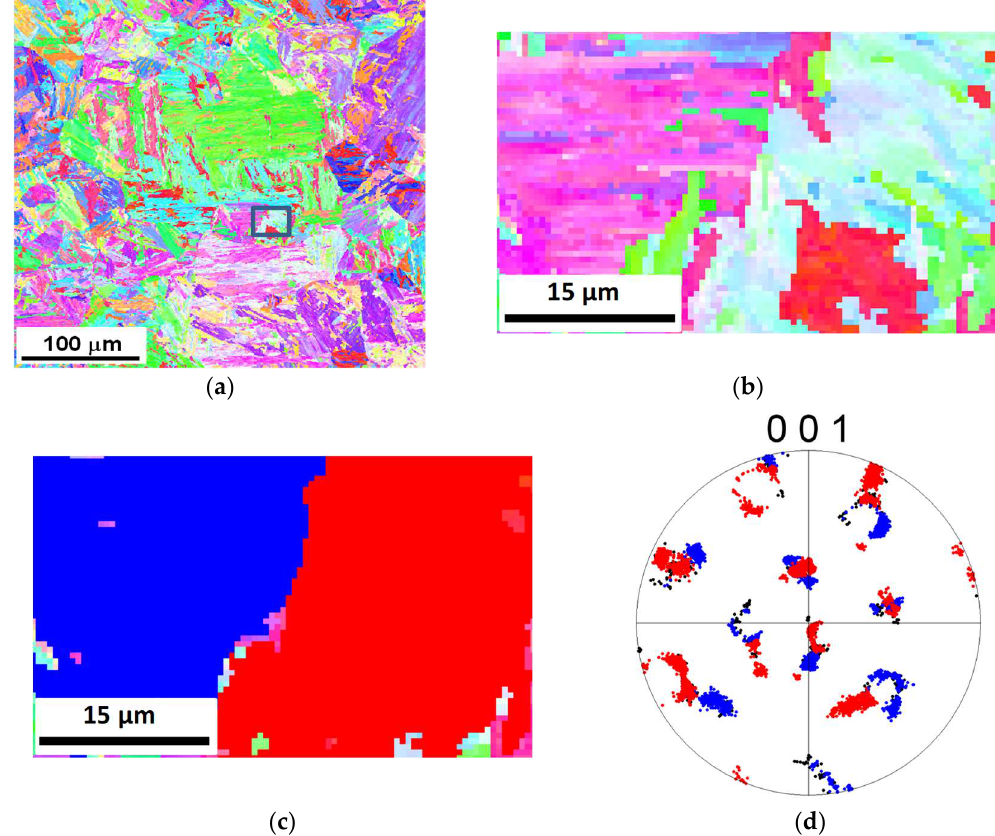
Figure 10 . ( a ) IPF (Inverse pole figure) ND orientation map from martensite marking the analysis area; ( b ) enlarged martensite IPF ND map of the analysis area; ( c ) martensite IPF ND map of the same area with red and blue colors superimposed to mark highlighted points in ( d ); ( d ) pole figure of the crystallographic data in ( b ) with points corresponding to areas in ( c ) highlighted using the same colors.